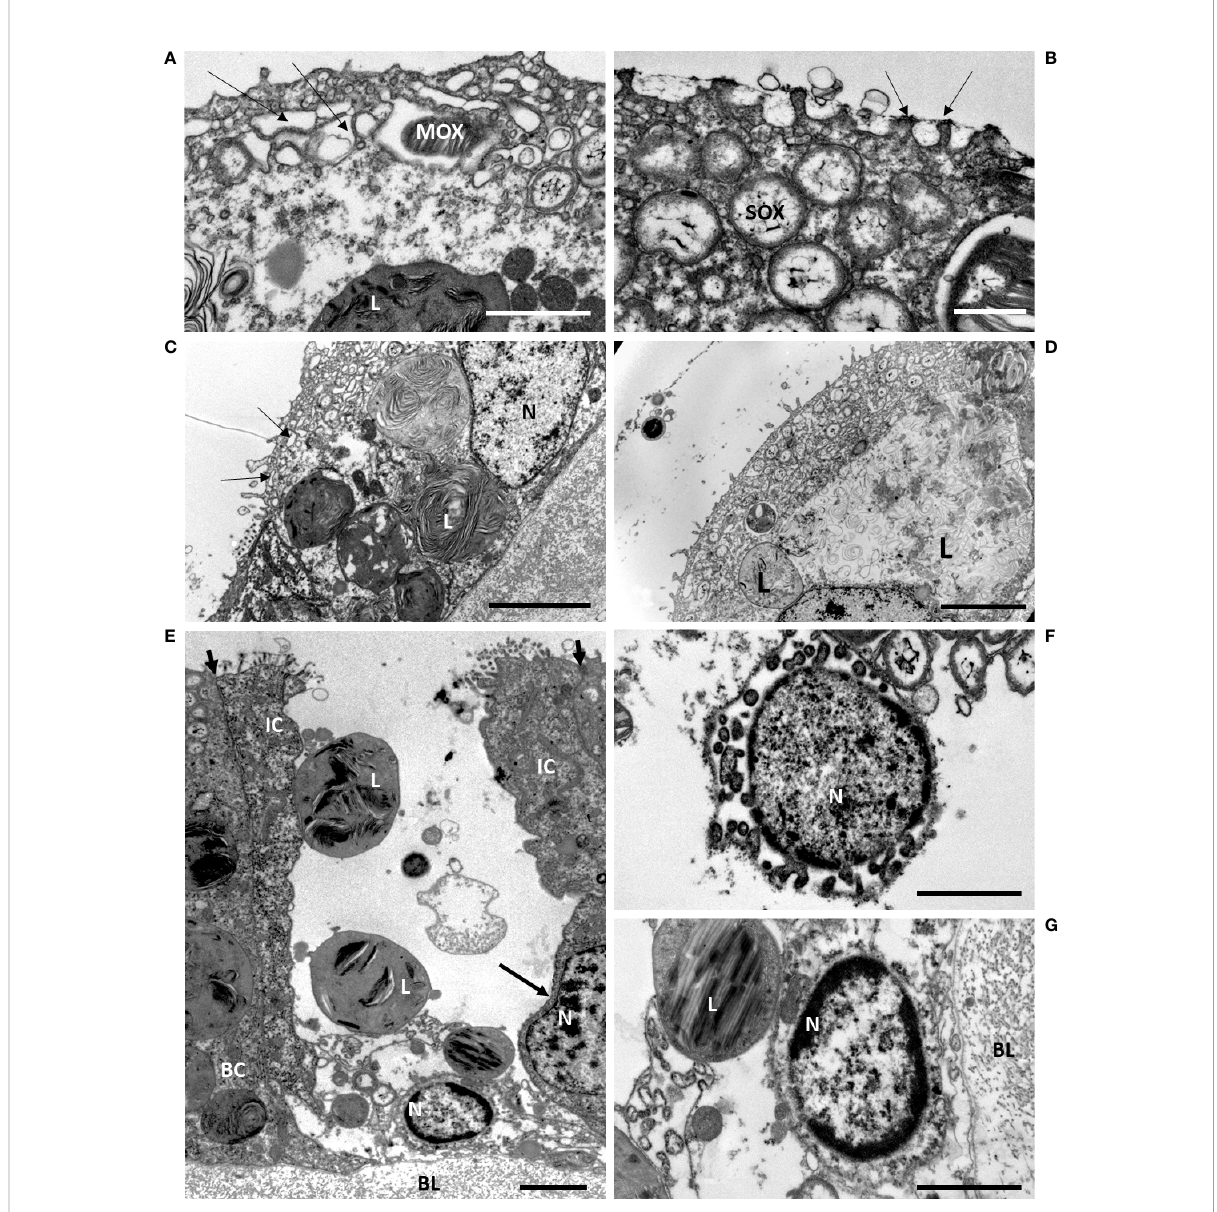
FIGURE 5 Early starvation effects on gill epidermis in B azoricus , at Menez Gwen, days d7 (A, C, D) and d9 (B, E, F, G) . On the fi gures (A – D) , many microvilli are present at the apical surface of the bacteriocyte. Note that they often bend towards each other, two by two, as pointed by the arrows in (B) . (A – C) the upper layer of the epidermis shows apical blebbing pointed by arrows in (A , C) i.e. phagocytic vacuoles that appeared empty, above a deeper layer of vacuoles containing a few symbionts. (C, D) the lysosomes containing onion-peel structures increase in size towards the basal part of the bacteriocytes. The symbiont shapes appear more or less recognizable on C (d7), but are much looser on D (d7); (E) this single bacteriocyte is missing its apical cell membrane and most of its cytoplasm, but still having some large lysosomes and its basal nucleus with condensed chromatin. This bacteriocyte is framed by two intact intercalary cells. The apical short arrows point to the tight junctions between each intercalary cell and their next neighbor cell and underline their narrowness. The intercalary cell to the right has an 8- shaped nucleus (long arrow) indicating it was possibly in the process of division. (F) Detail of another empty bacteriocyte with its nucleus showing condensed chromatin and budding at is periphery. (G) Close view of the basal nucleus with peripheric condensed chromatin shown in (E) . BC, bacteriocyte; BL, basal lamina; IC, intercalary cell; L, lysosome; MOX, methane-oxidizing symbiont; N, nucleus; SOX, sul fi de-oxidizing symbiont. Scale bars represent 2µm in (A, B, F, G) and 5 µm in (C, D, E)